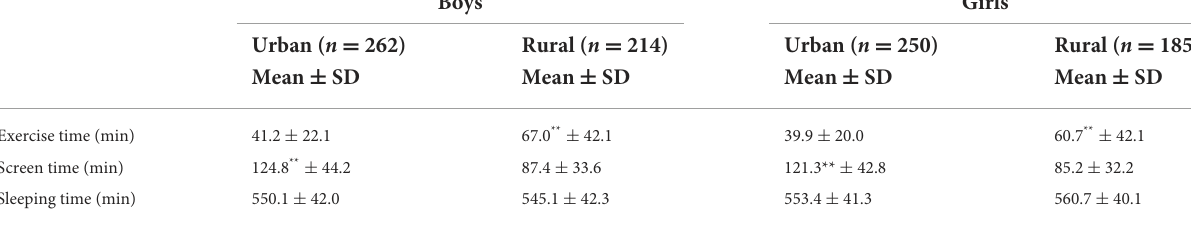
TABLE 4 Daily exercise time, screen time and sleeping time for urban and rural